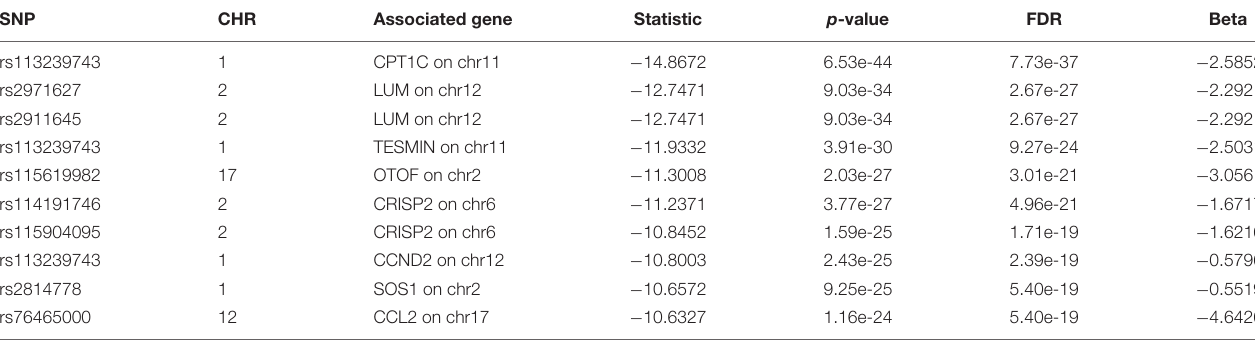
TABLE 4 | Top 10 most significant SNP-gene pairs identified by our trans- eQTL analysis. SNP CHR Associated gene Statistic p -value FDR